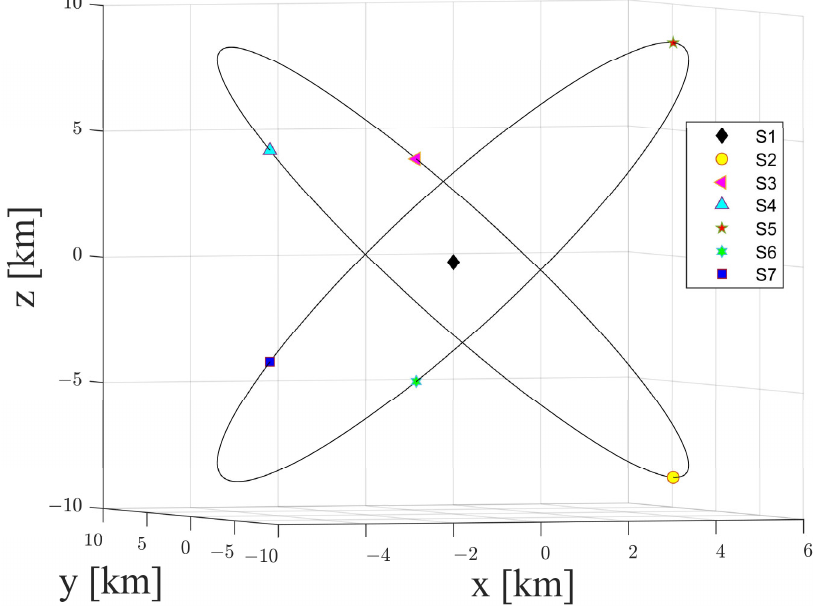
Figure 9. Seven-satellite space-circle formation in the Hill frame centered at S 1 (space-circle radius of 10 km). Table 2. Orbit elements of the seven-satellite space-circle formation (space-circle radius of 1 km). Orbit Elements